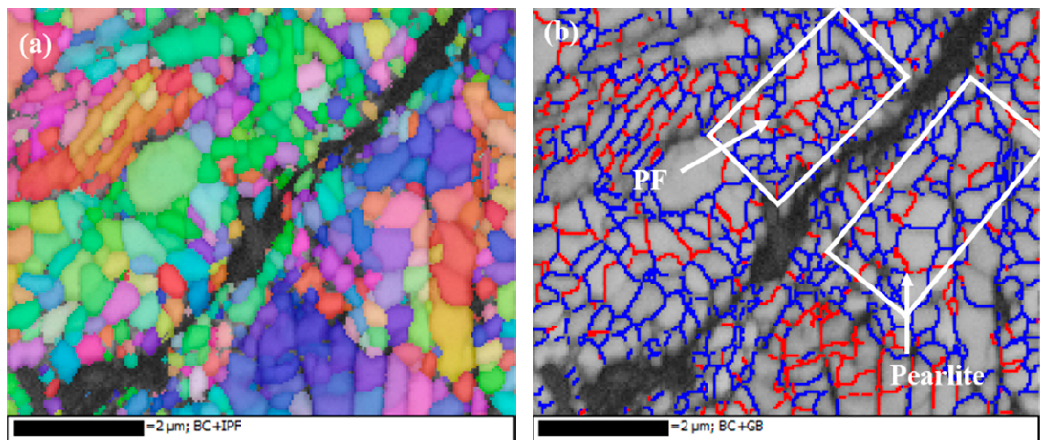
Figure 15. The EBSD micrographs of propagation of RCF cracks at the interface between proeutectoid